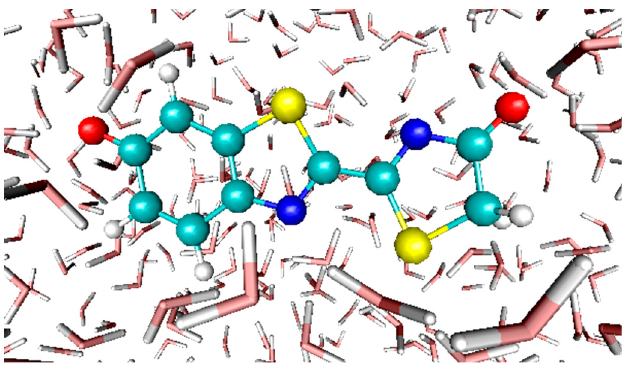
Figure 9. Representation of the system under study: oxyluciferin (CPK drawing method) and the water molecules mimicking water solution.